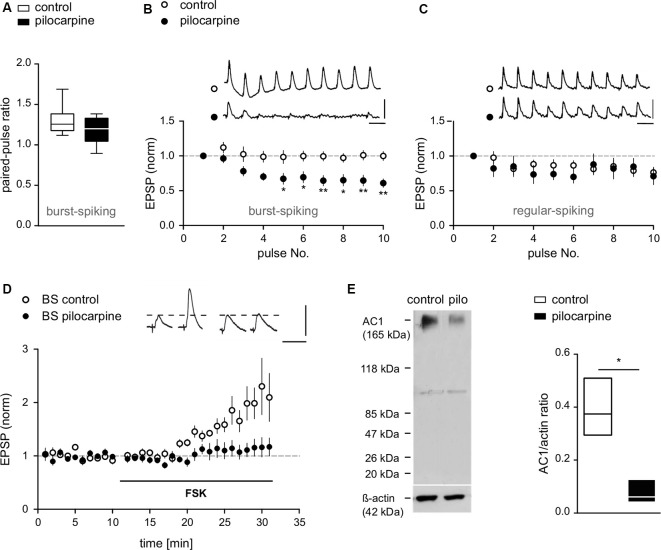
Compromised presynaptic release machinery in BS cells from pilocarpine-treated animals. (A) PPF of EPSPs recorded from BS cells in control and pilocarpine-treated animals shown as box plots with whiskers from minimum to maximum and line at median (Control BS: PPR = 1.3 ± 0.06, n = 8, Pilo BS: PPR = 1.2 ± 0.04, n = 12, p = n.s). (B) EPSP responses upon repetitive stimulation (10 pulses at 10 Hz) in BS cells from control and pilocarpine-treated rats. In pilocarpine-treated animals, we observed a strong decline of the EPSP amplitude upon the 4th to 10th stimulus (Control BS: −0.1 ± 1%, n = 8, Pilo BS: −36.5 ± 1.3%, n = 10). (C) EPSP responses upon repetitive stimulation (10 pulses at 10 Hz) in RS cells from control and pilocarpine-treated rats. In control animals (n = 8), six cells showed weak depression, one cell showed no effect and one cell showed an increase in EPSP amplitude. In pilocarpine-treated animals (n = 9), seven cells showed weak depression, one cell showed no effect and one cell showed an increase in EPSP amplitude. There was no statistical difference between control and pilocarpine-treated animals (Control RS: −19.8 ± 0.9%, n = 8, Pilo RS: −20.7 ± 4.2%, n = 9). Scale bars: 5 mV and 100 ms. (D) In control BS cells, application of forskolin (FSK) caused a potentiation of EPSPs (FSK: 100.4 ± 7.9%, n = 7) while in BS cells from pilocarpine-treated animals, forskolin failed to induce LTP (FSK: 13.4 ± 1.3%, n = 8). Scale bars: 5 mV and 50 ms. (E) Left: protein immunoblot analysis of AC1 expression in subicular slices. Protein expression of AC1 was detected in membrane-enriched protein extracts from the subiculum of control and pilocarpine-treated rats. Equal loading conditions were verified by immunodetection for actin. An immunoreactive band at approximately 123 kDa, representing AC1 protein was detected with reduced expression in pilocarpine-treated samples. Sizes of relevant marker proteins in kDa are shown in the left margin. Faint lower bands at approximately 100 kDa are of unknown origin, possibly due to protein degradation. Right: quantification of AC1 and actin immunreactive bands in membrane-enriched protein extracts from the subiculum of control and pilocarpine-treated rats shown as floating bars with line at median (AC1/actin ratio Control: 0.39 ± 0.06, n = 3; AC1/actin ratio Pilo: 0.08 ± 0.03, n = 3, p = 0.04). Statistical significance was set to *p < 0.05, **p < 0.01.